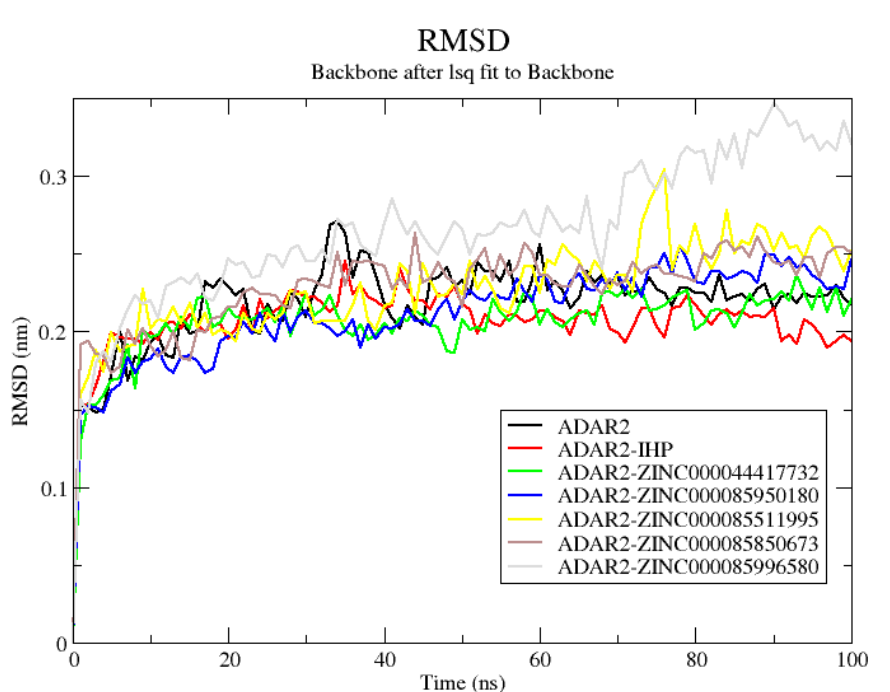
Figure 5. RMSD plot of the unbound ADAR2 and ADAR2-ligand complexes. The unbound protein, ADAR2-IHP, ZINC000044417732, ZINC000085950180, ZINC000085511995, ZINC000085850673, and ZINC000085996580 complexes are colored black, red, green, blue, yellow, brown, and grey, respectively. The ADAR2-ZINC000085511995 complex was mostly stable throughout the simu- lation period. It reached relative equilibrium at around 10 ns (0.225 nm), maintained stability till 75 ns where the RMSD rose to ~0.3 ns and fell to 0.25 nm (around 80 ns) ZINC000085734971, and ADAR2-ZINC000085850673 complexes experienced similar